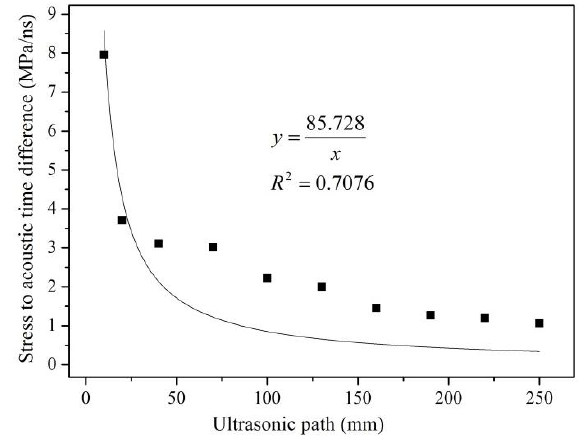
Figure 9. Fitting trend line between probe distance and the SATD factor of steel plate C.